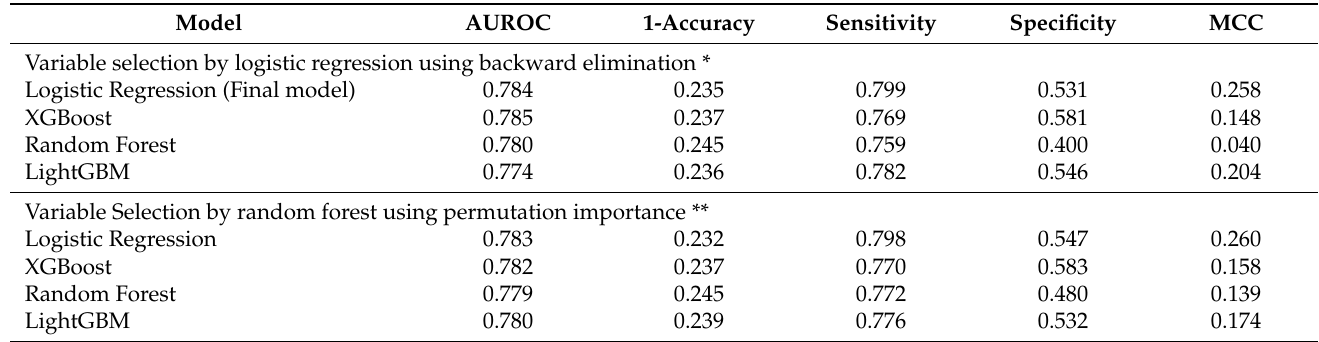
Table 4. Summary of the predictive performance of each prediction